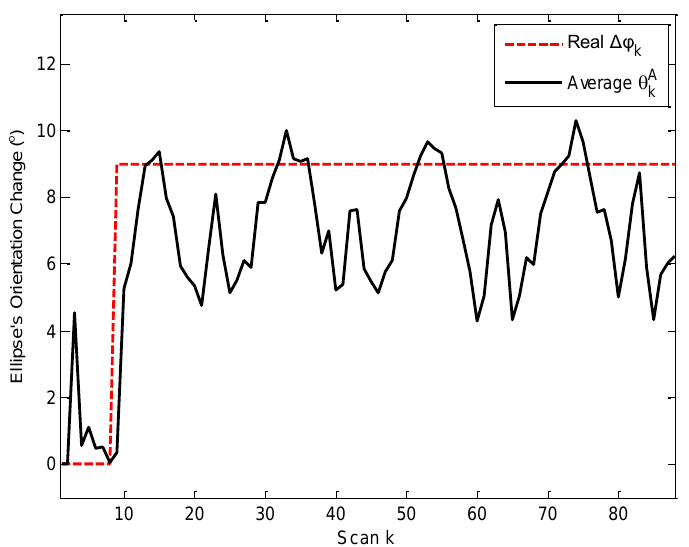
 A in simulation scenario 1. k